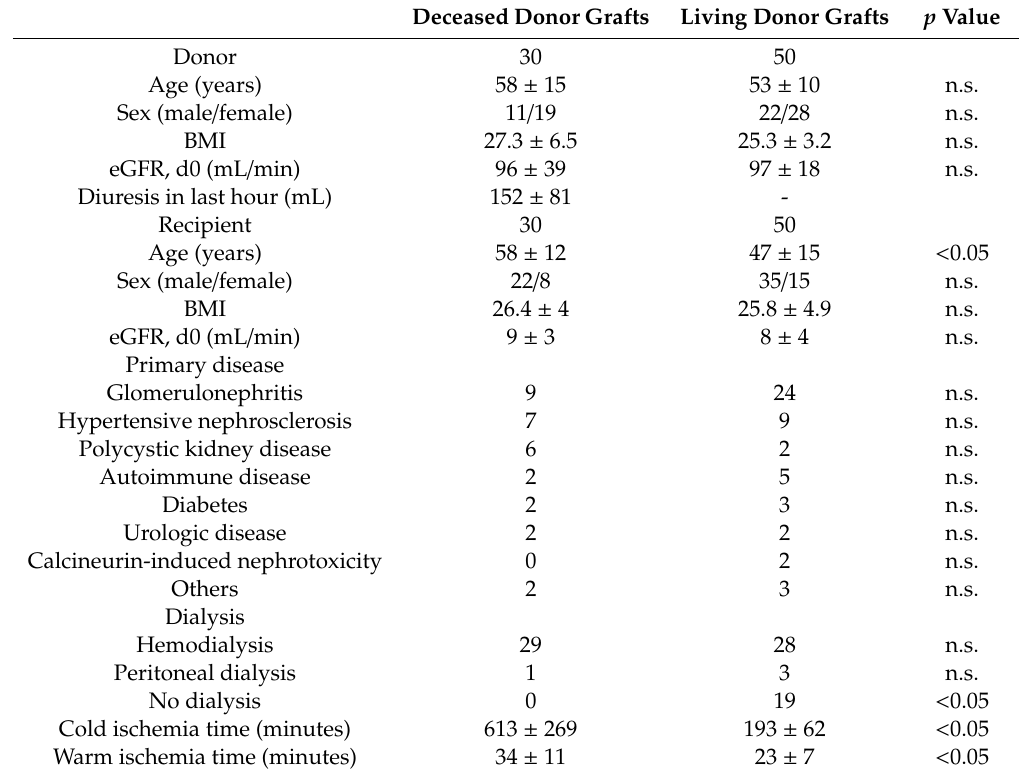
Table 1. Demographic data of donors and recipients.